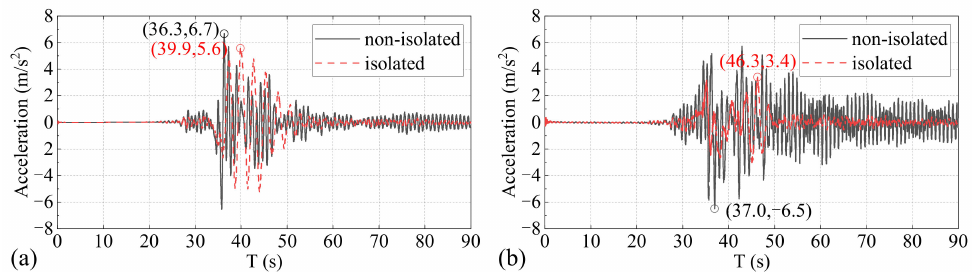
Figure 10. The acceleration time histories of the girder B2 point. ( a ) X-direction. ( b )